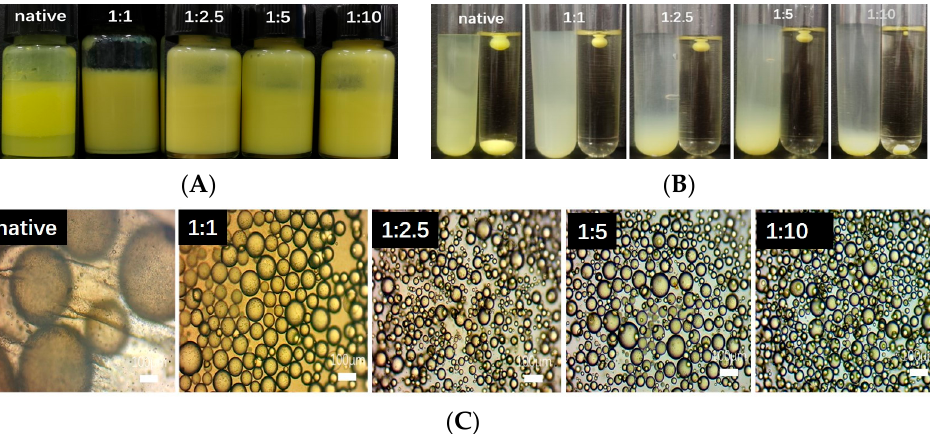
Figure 5. ( A )Visual appearances of emulsions stabilized by native quercetin and antisolvent-treated quercetin at antisolvent ratios of 1:1, 1:2.5, 1:5, 1:10; ( B ) Droplet test results of emulsions stabilized by native quercetin and antisolvent-treated quercetin at antisolvent ratios of 1:1, 1:2.5, 1:5, 1:10; ( C ) Optical microscopy images of emulsions stabilized by native quercetin and antisolvent-treated quercetin at antisolvent ratios of 1:1, 1:2.5, 1:5, 1:10. In Figure 5B, emulsion was dropped into pure water (left tube) and pure oil (right tube), respectively. The emulsions were stabilized by 1% quercetin particle and the oil fraction is 0.5. The scale bar is 100 µm.